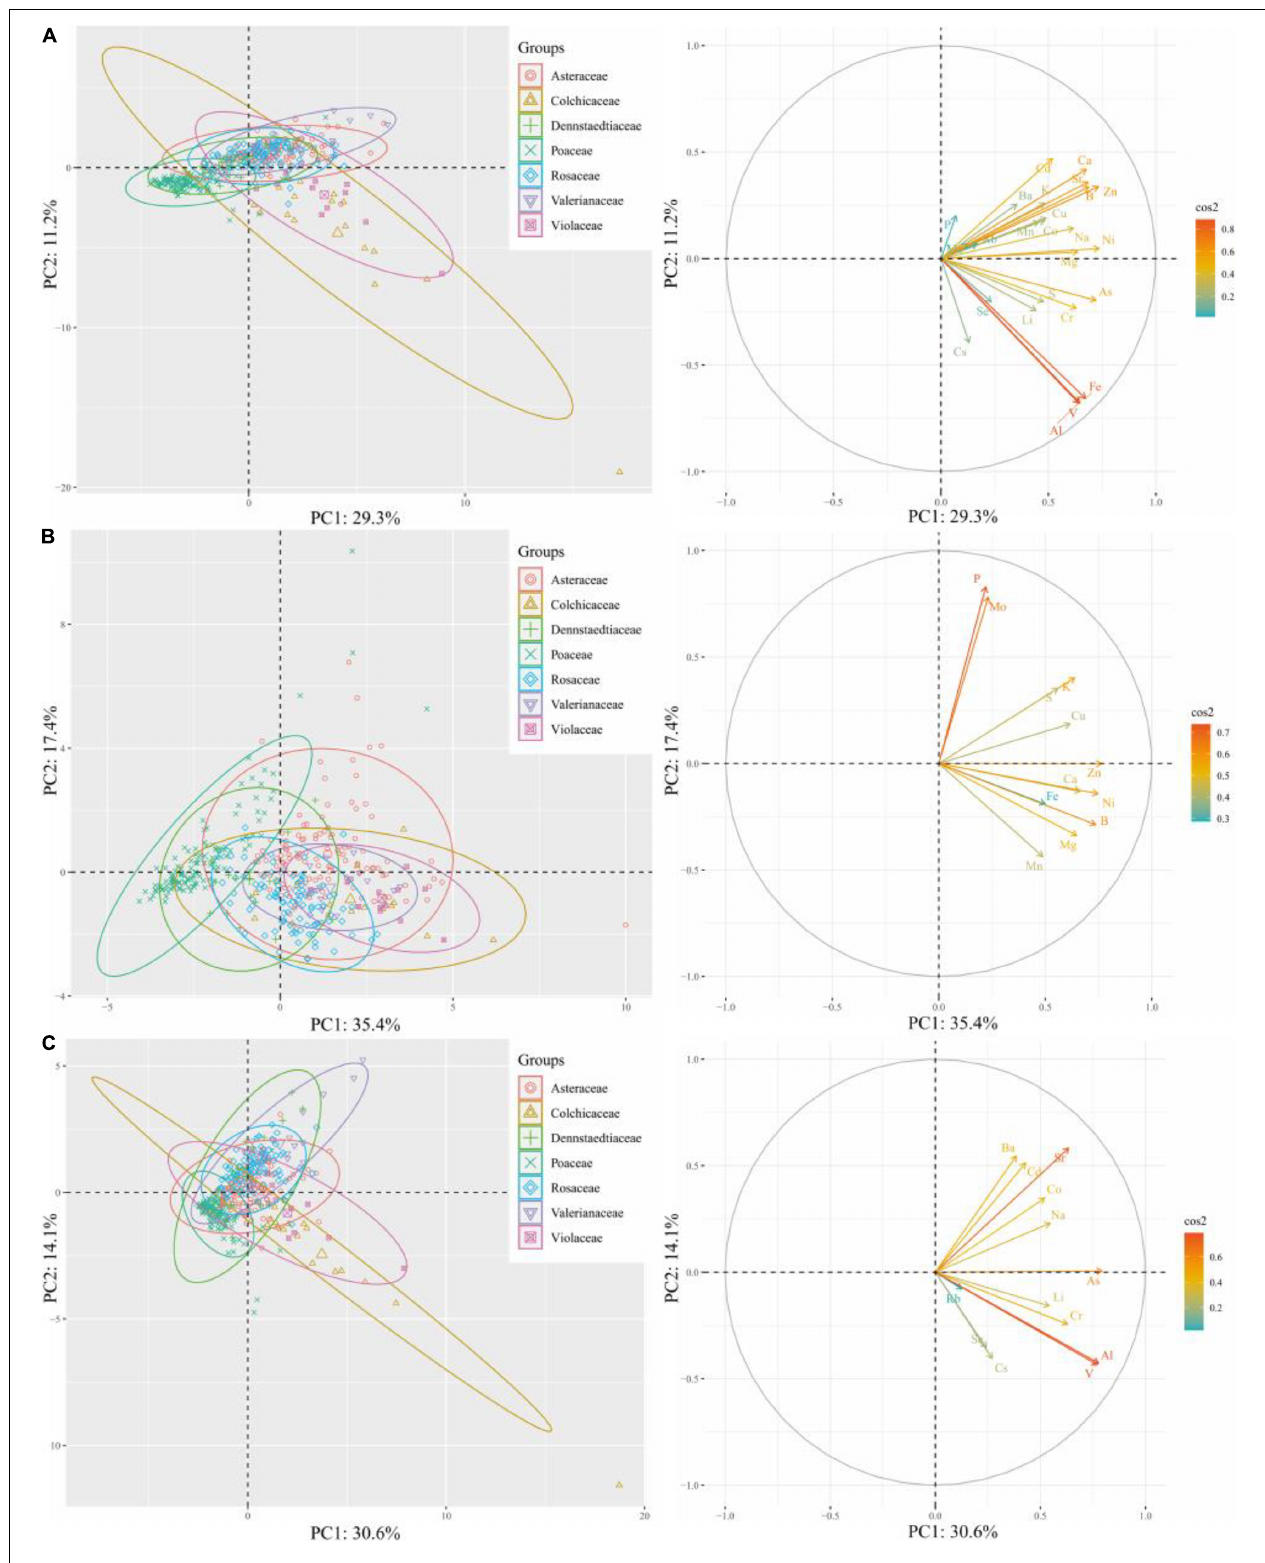
FIGURE 7 | Principal component analysis (PCA) of elements in the leaves of plant species from different families. Scores on PC1 and PC2 with (A) all elements, (B) essential elements, and (C) non-essential elements, as well as the corresponding loading plots, respectively, were included.